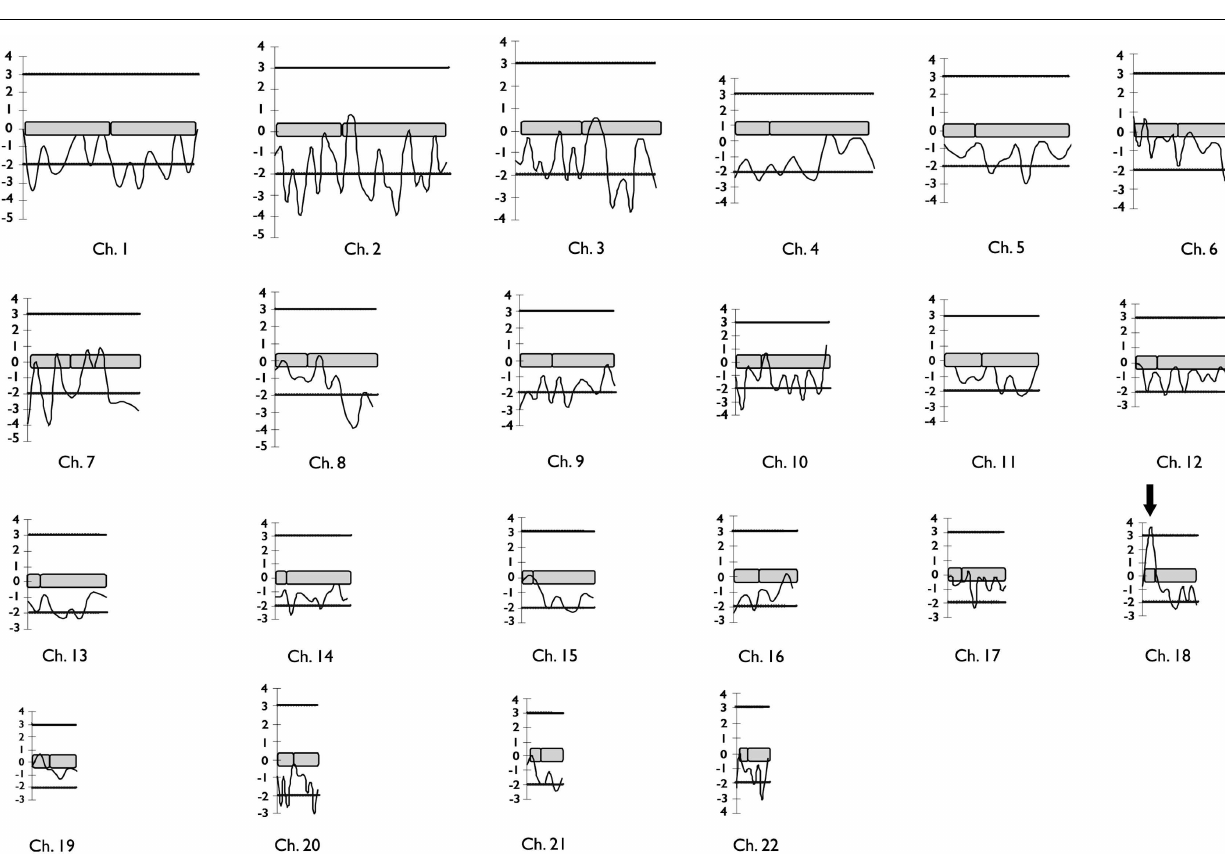
FIGURE 1 | Diagram representing the results of two-point LOD scores for the 332 microsatellites markers genotyped in the genome-wide linkage study of F-10 segregating familial mesial temporal lobe epilepsy.